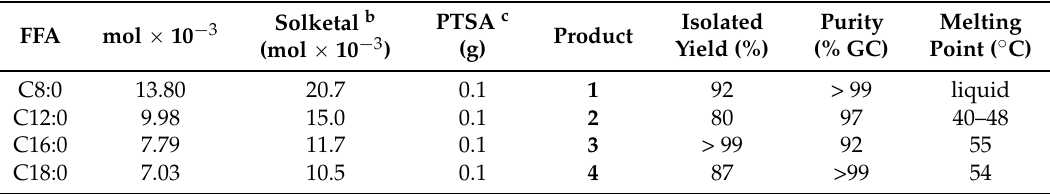
Table 1. Reactions between solketal and FFAs a .